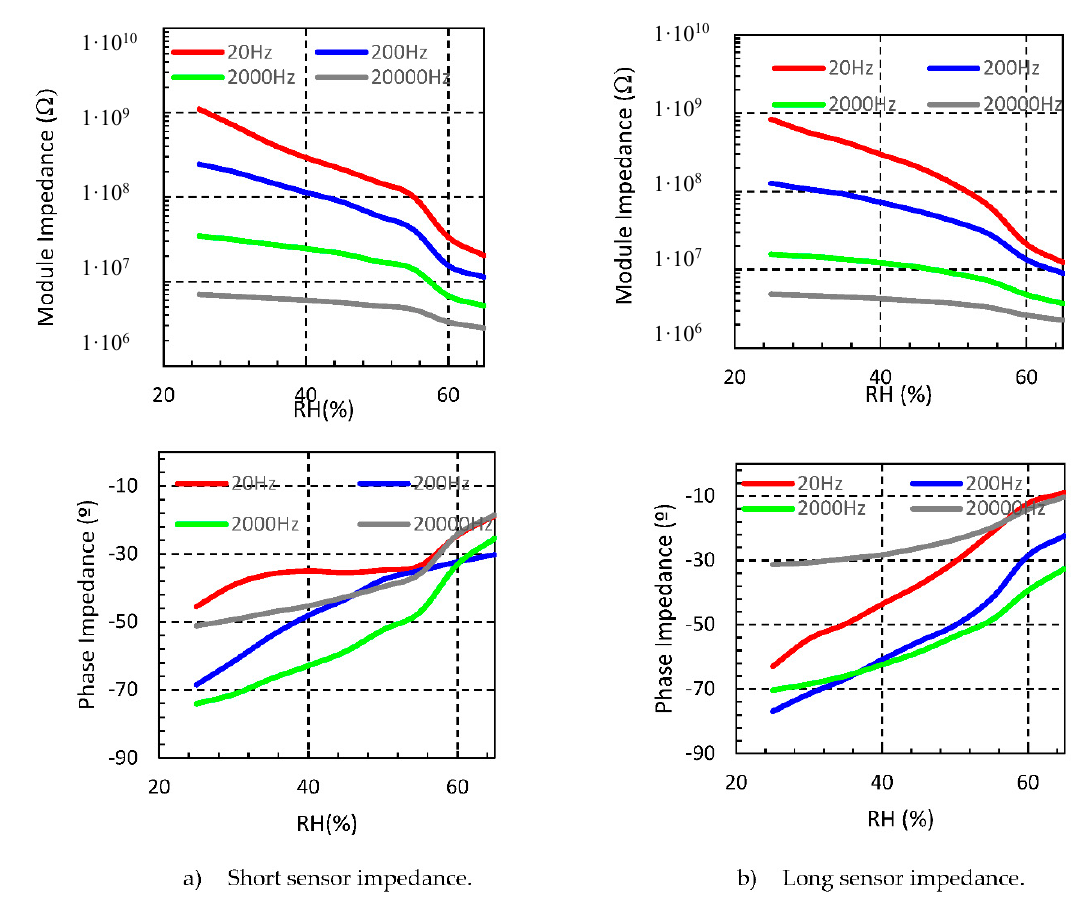
Figure 3. Measured sensors impedance from 25% to 65% RH at different frequencies (T = 20 °C).